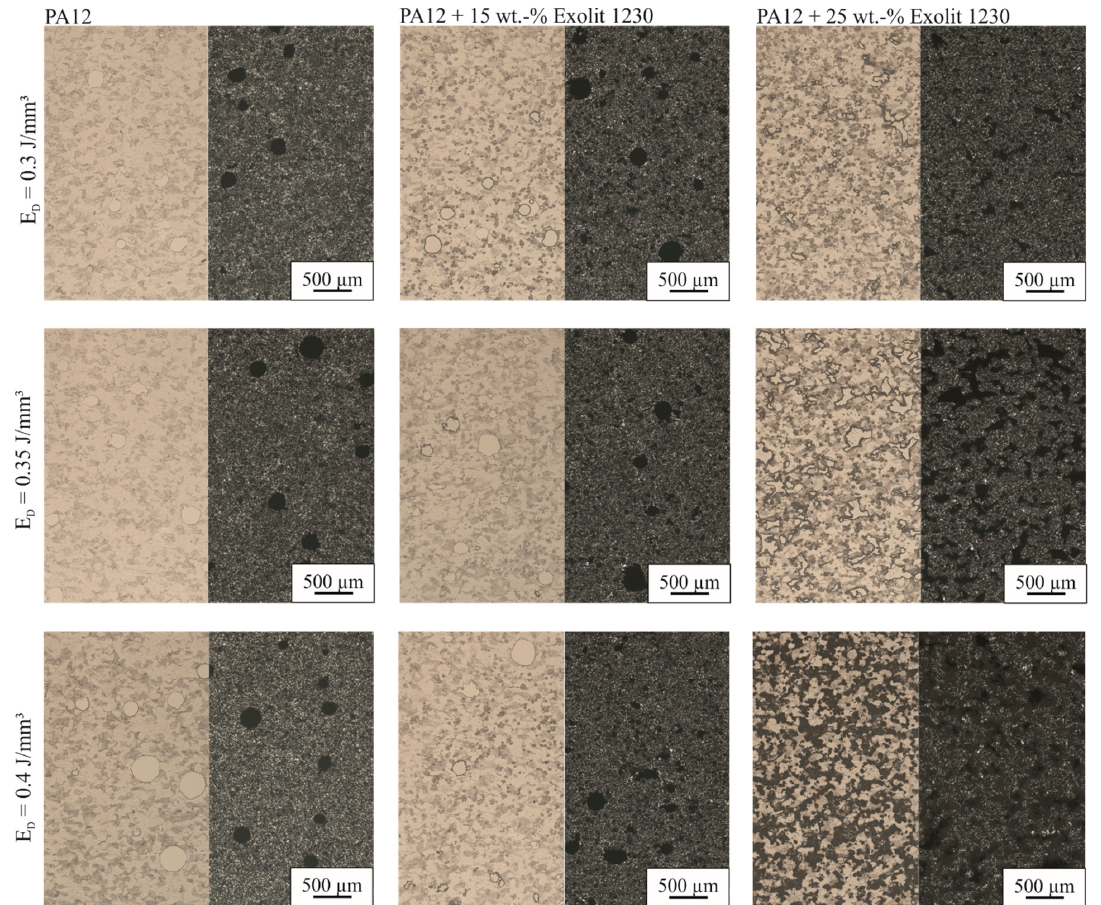
Figure 11. Microscopy images (bright field and polarized light) of the laser-sintered density cubes for different flame retardant concentrations and energy densities. di ff erent flame retardant concentrations and energy